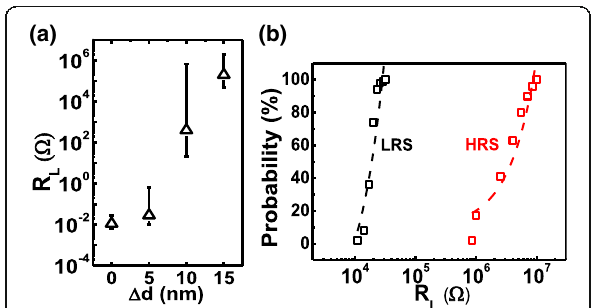
Fig. 2 a The measured initial resistance of STI-RRAM samples with different △ d. b Cumulative probability of the loading resistance after reset/set of the STI-RRAM at both high- and low-resistance states